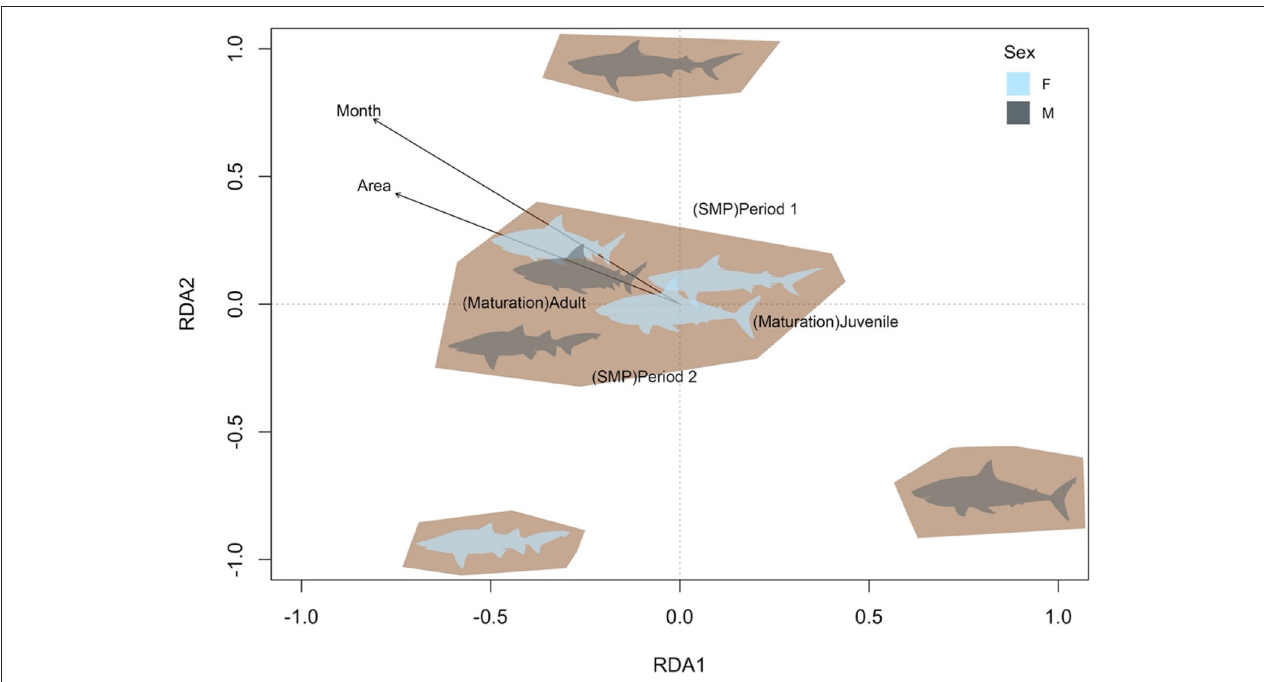
FIGURE 3 | RDA triplots (first two axes from the redundancy analysis RDA1 and RDA2) of the total catch of female and male (colour legend) grey nurse, white, tiger and bull sharks in the Shark Meshing Program (SMP) between 1998 and 2019 according to the significant groupings identified (shaded areas) and constrained by the corresponding significant variables maturation status (Maturation), month, SMP period (SMP) and netted area (Area). Arrows represent the positive increments for the continuous variables (month and